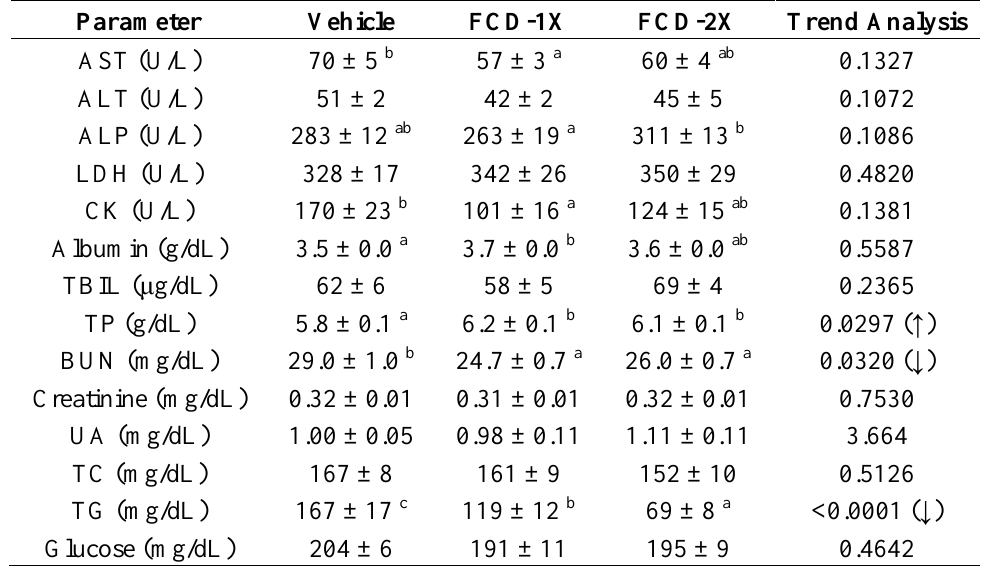
Table 2. Biochemical analysis of the FCD treatment groups at the end of the experiment.